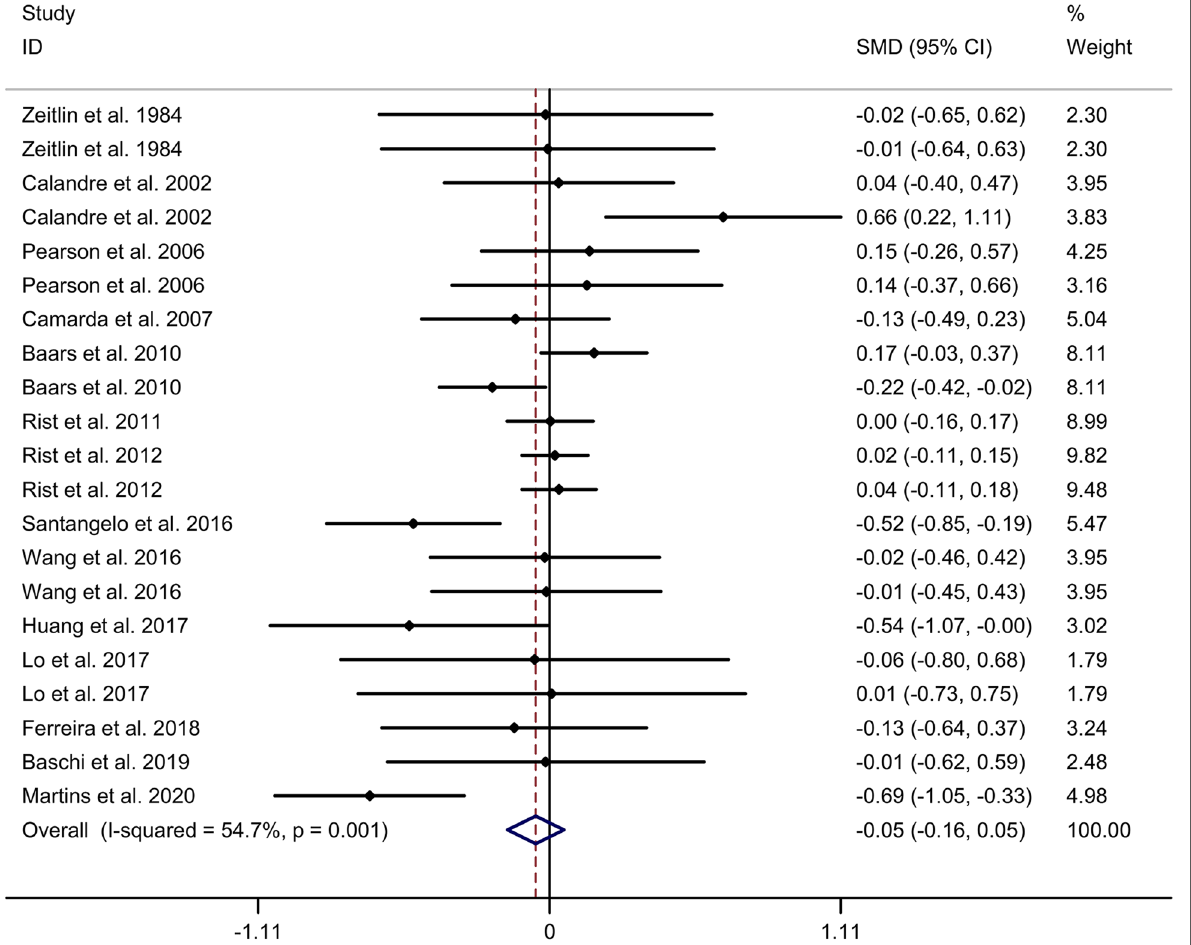
Fig. 5 Forest plots regarding comparison in executive function between migraine group and no migraine group. Abbreviations: CI, confidence interval; SMD, standard mean